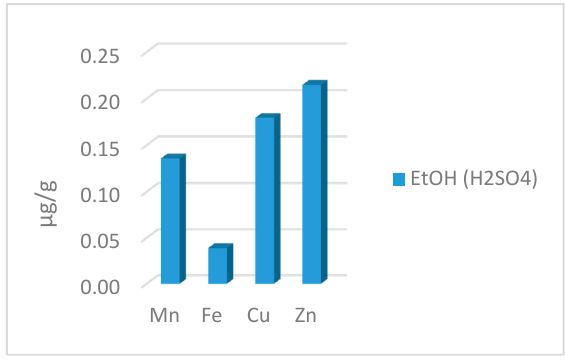
Figure 2. Concentration of metals in ethanol after the extraction of cigarette butts.